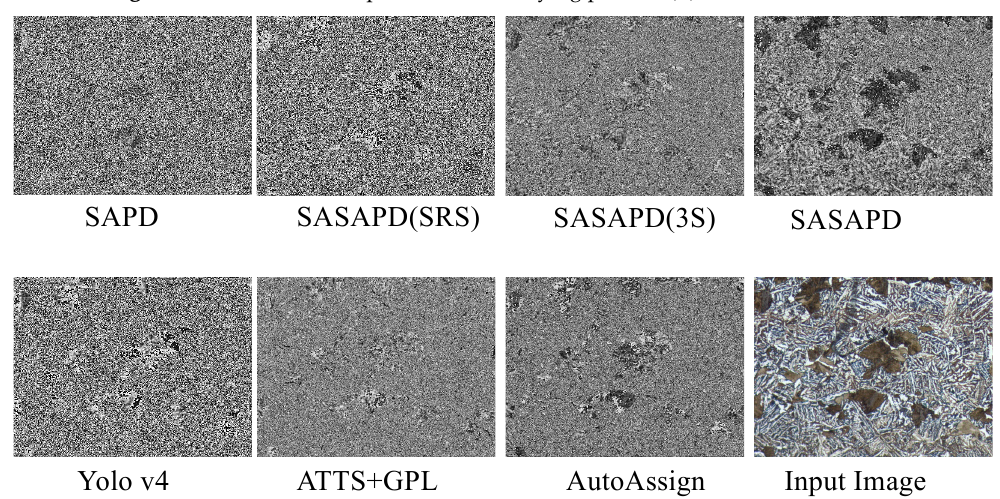
Figure 12. The visual comparison of the feature maps obtained by different